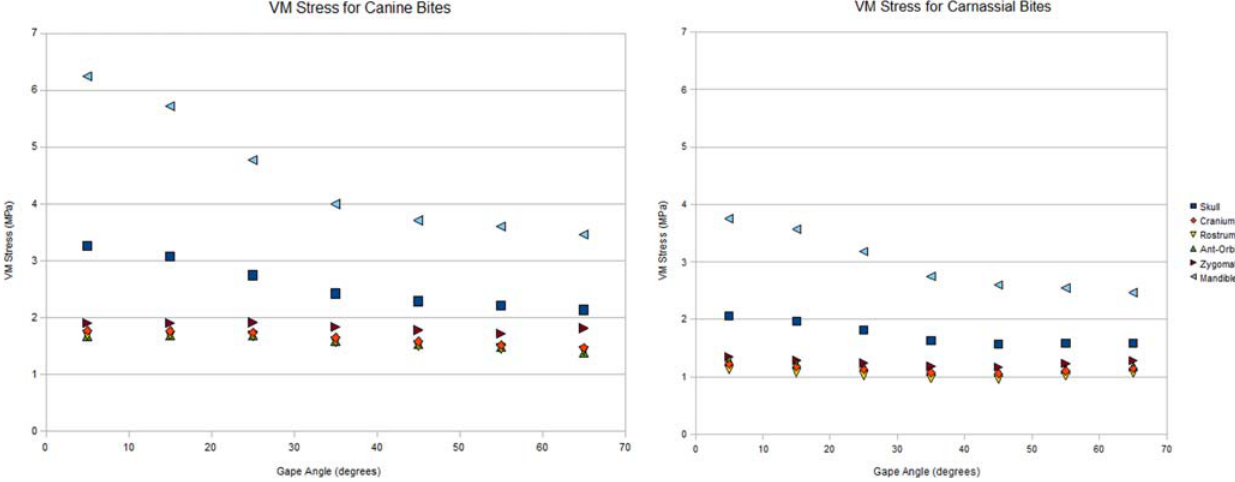
Figure 2. Comparison of stress distribution along the skull during each freedom case.